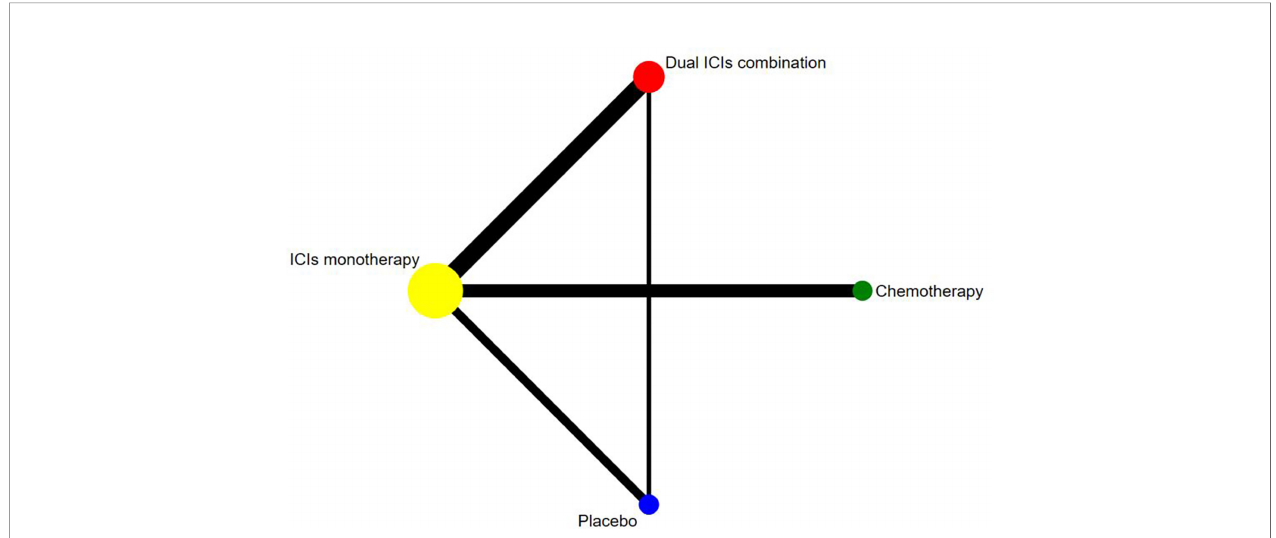
FIGURE 2 | Network established for comparisons based on four treatment groups. Circular nodes indicate treatment regimens. The node size corresponds with the total number of patients randomized to receive the treatment. Each line represents a type of head-to-head comparison. The width of the lines is proportional to the number of trials comparing the connected